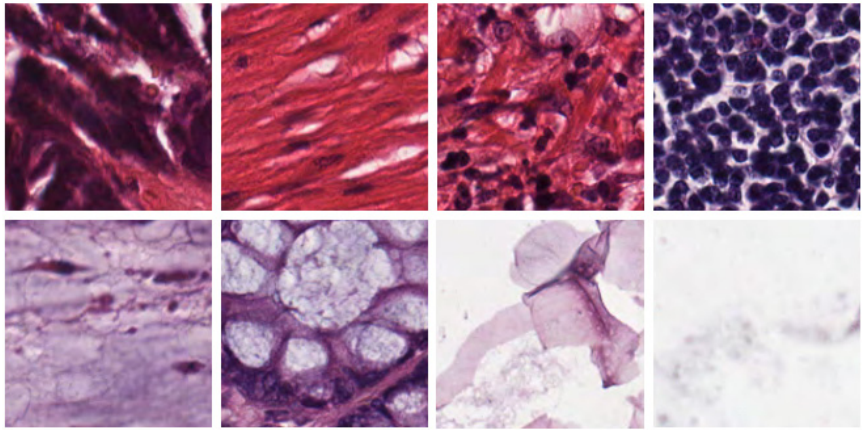
Figure 3. Sample images from a CRC dataset: ( top row ), endoscopy images, and ( bottom row ), histological whole slide images (WSI).